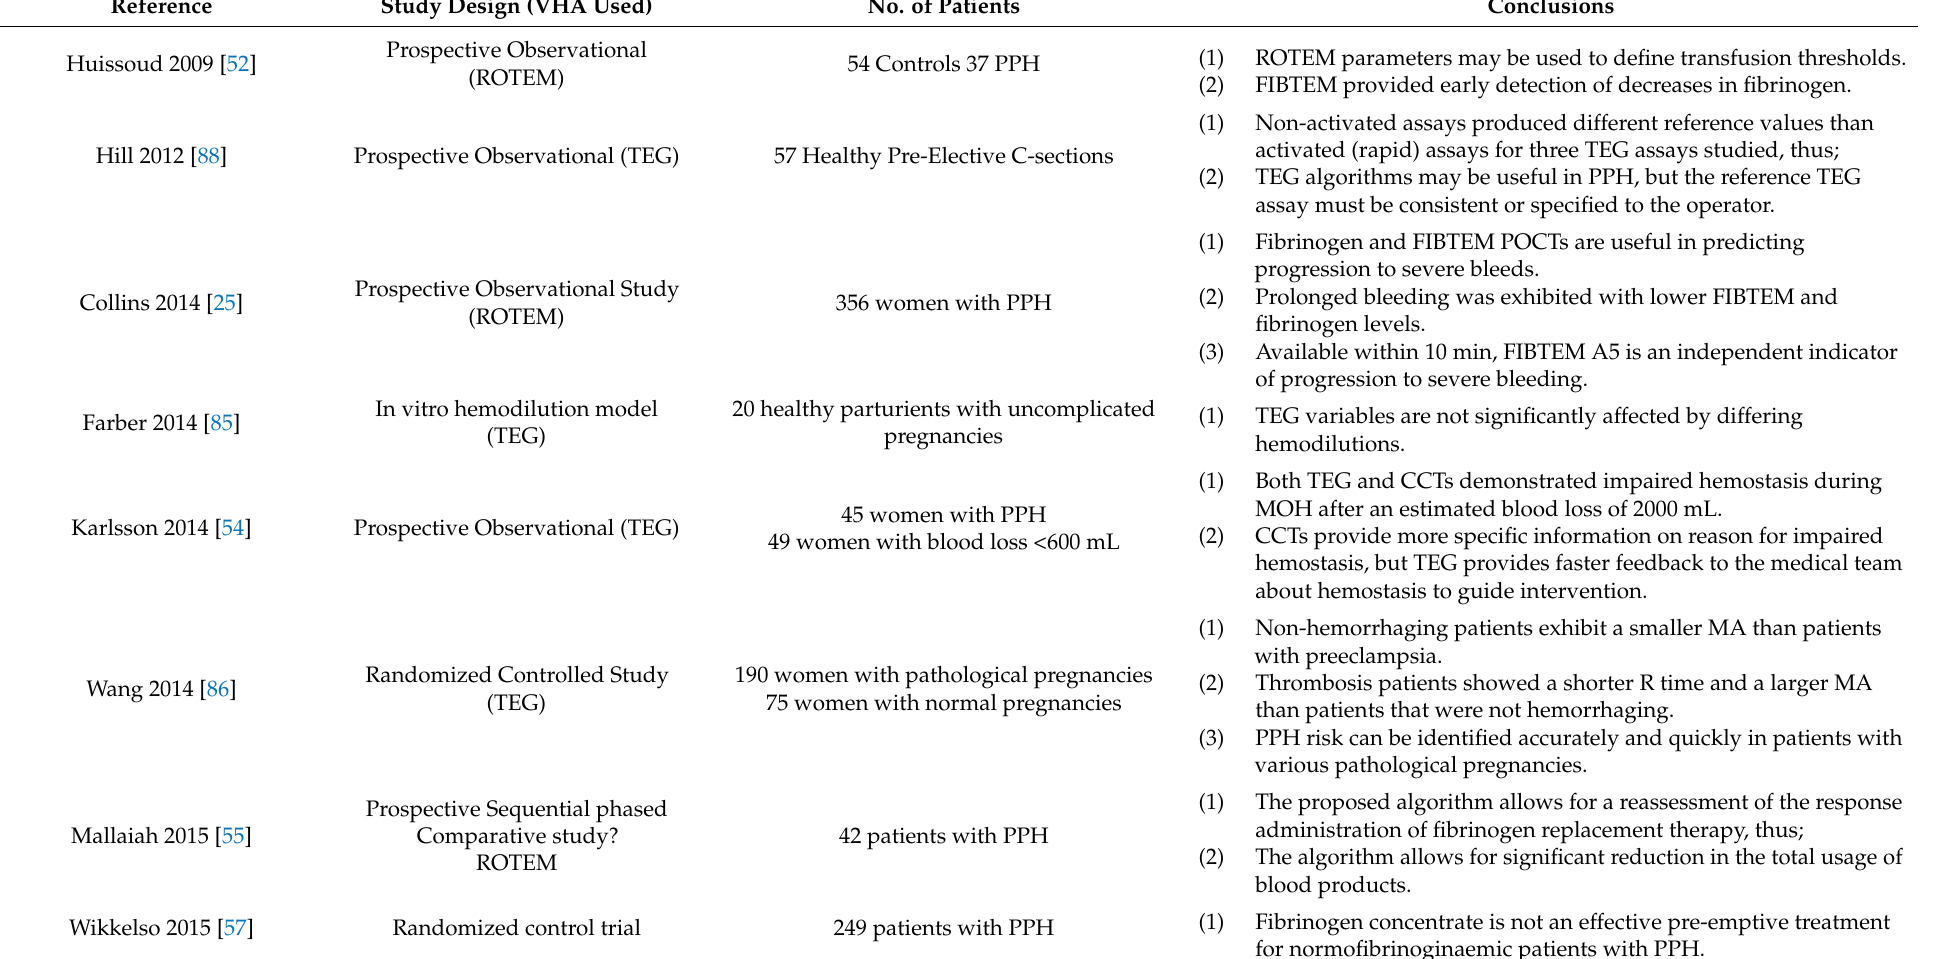
Table 1. Review of salient literature regarding VHAs and their utility in